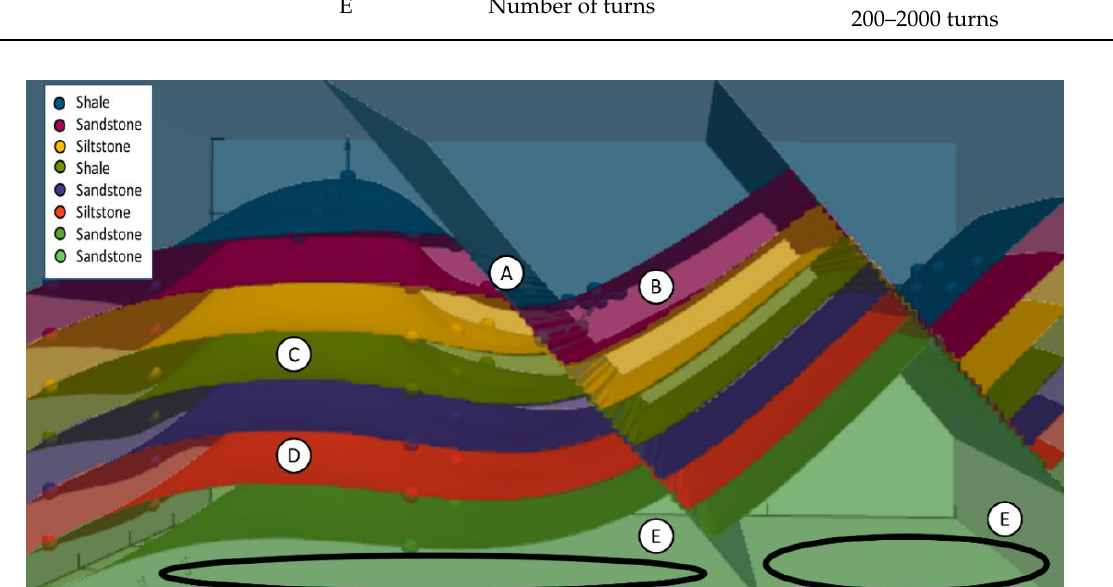
Figure 6. Base case study model obtained using GemPy [55,56]. The uncertainties related to the case study are located from A to E and described in Table 1.